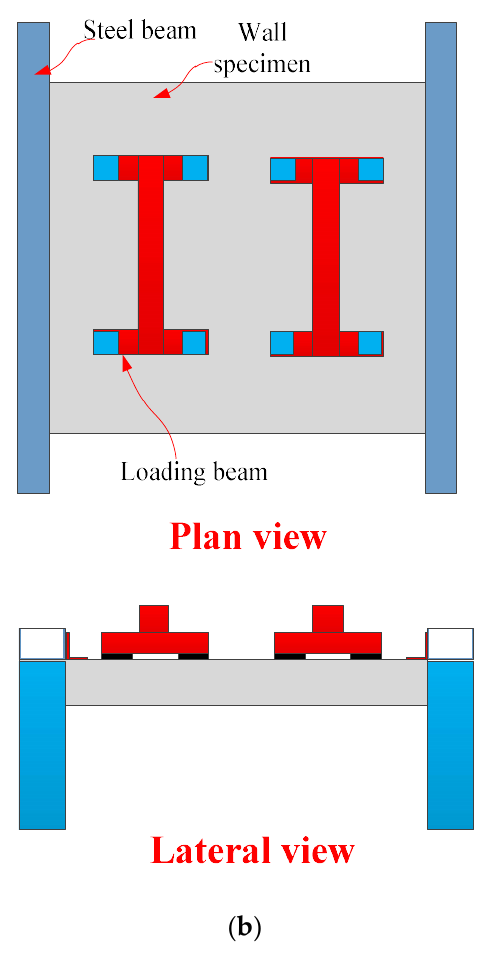
Figure 3. Test setup. ( a ) Loading in a positive direction. ( b ) Loading in a negative direction.